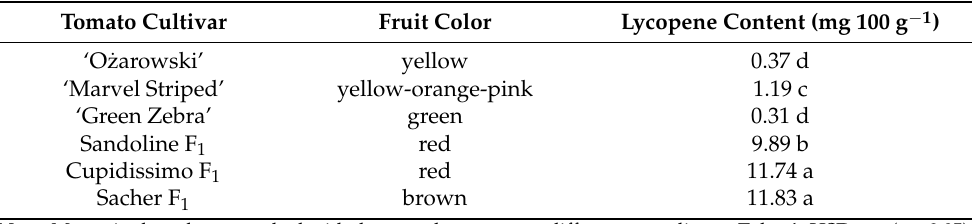
Table 1. The lycopene content in tomato fruit of various cultivars with different colors. Tomato Cultivar